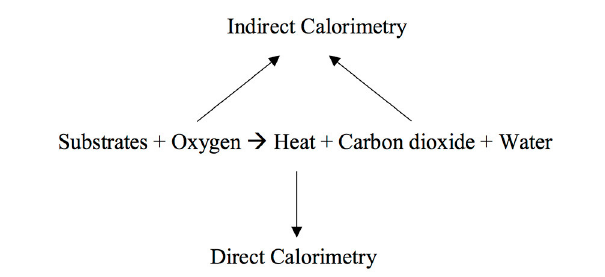
FIGURE 1 | Direct calorimetry measures heat production and indirect calorimetry measures gas exchange: oxygen consumption and carbon dioxide